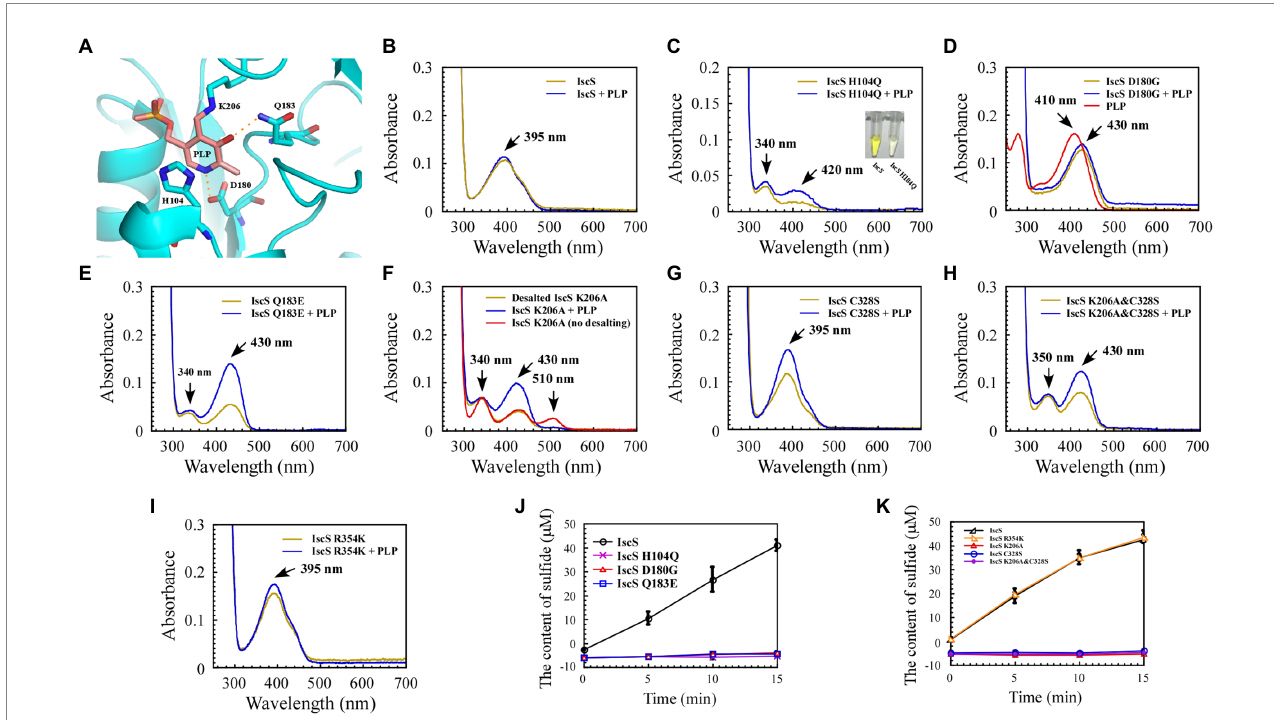
FIGURE 4 Mutation of the key residues of Escherichia coli IscS resulted in a set of intermediates generated in vivo during the CD reaction. (A) Active site structure of E. coli IscS. The PLP and PLP-binding residues are shown in the sticks model. The PLP cofactor makes a covalent link to Lys206. Polar interactions stabilising the position of PLP in the active site are indicated by orange dashed lines. This image was generated using PyMOL; (B–I) UV–visible spectral changes of purified wild-type IscS and IscS variants (H104Q, D180G, Q183E, K206A, C328S, K206A&C328S, R354K) are expressed in the E. coli wild-type cells, with or without PLP (100 μ M). The insert in (C) is a photograph of IscS and IscS H104Q proteins purified from the E. coli wild-type cells. All proteins we obtained followed a protein purification protocol in which the solution (with or without exogenous PLP) is incubated for 30 min on ice as soon as the E. coli cells pass through an NS1001L2K high-pressure cell cracker, and they are purified by a Ni-agarose column (Qiagen co.) and then desalted by a gel filtration desalting column (SuperdexTM 75 10/300GL, GE). The protein concentration was calibrated to approximately 25 μ M with buffer A. (No desalting in F ) IscS K206A was measured by UV–visible spectra after being purified through a Ni-agarose column without desalting. Prepared overexpressed CDs always contain apoproteins; + PLP in (B–I) indicates that the purified IscS and IscS variants bind to exogenous PLP saturated in vitro ; (J,K) Effects on the activity of wild-type E. coli IscS and IscS variants purified from E. coli wild-type cells. The protein concentration was calibrated to 5 μ M with buffer A. CD activity of IscS and IscS variants was measured using Siegel’s sulphide detection method (Siegel, 1965). All data were obtained from three independent